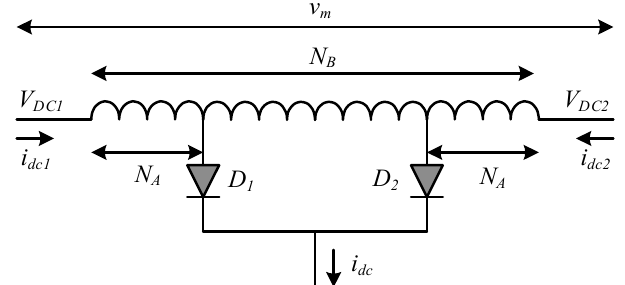
Figure 6. The optimal PDT structure.